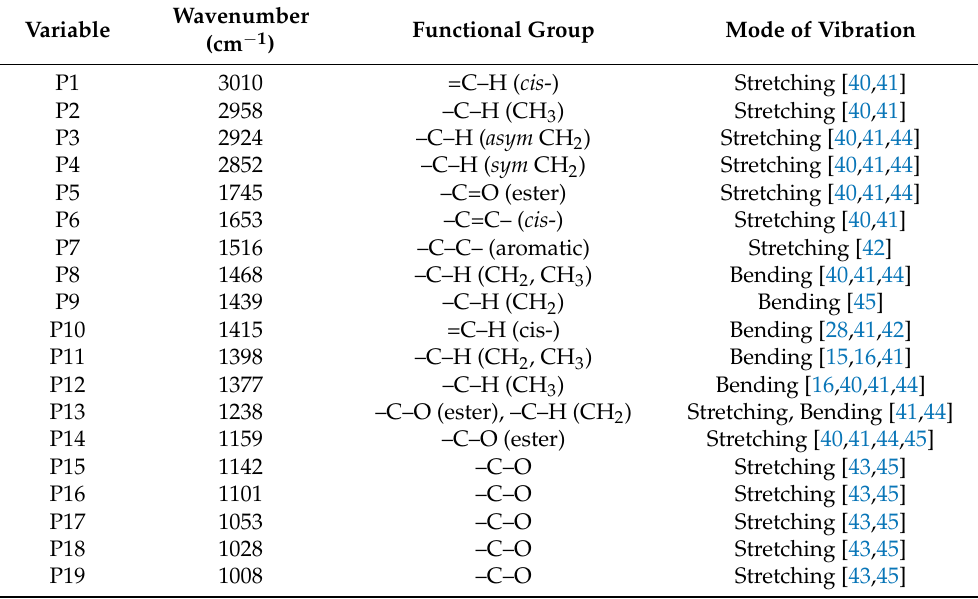
Table 1. Assignment of peaks in the second-derivative FT-IR spectrum of red pepper